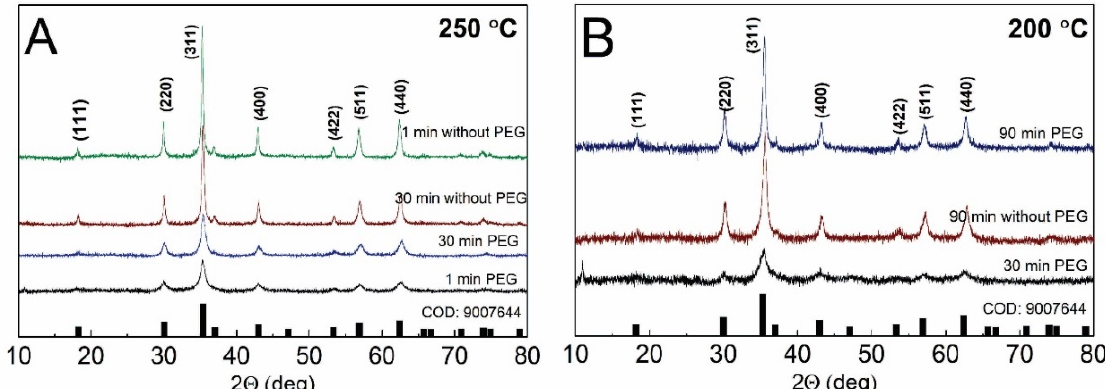
Figure 3. XRD diffractograms of Fe 3 O 4 particles at synthesis temperatures of 250 °C ( A ) and 200 °C ( B ). The diffractograms of different synthesis times are presented, as well as a presence of PEG in the reaction mixture.